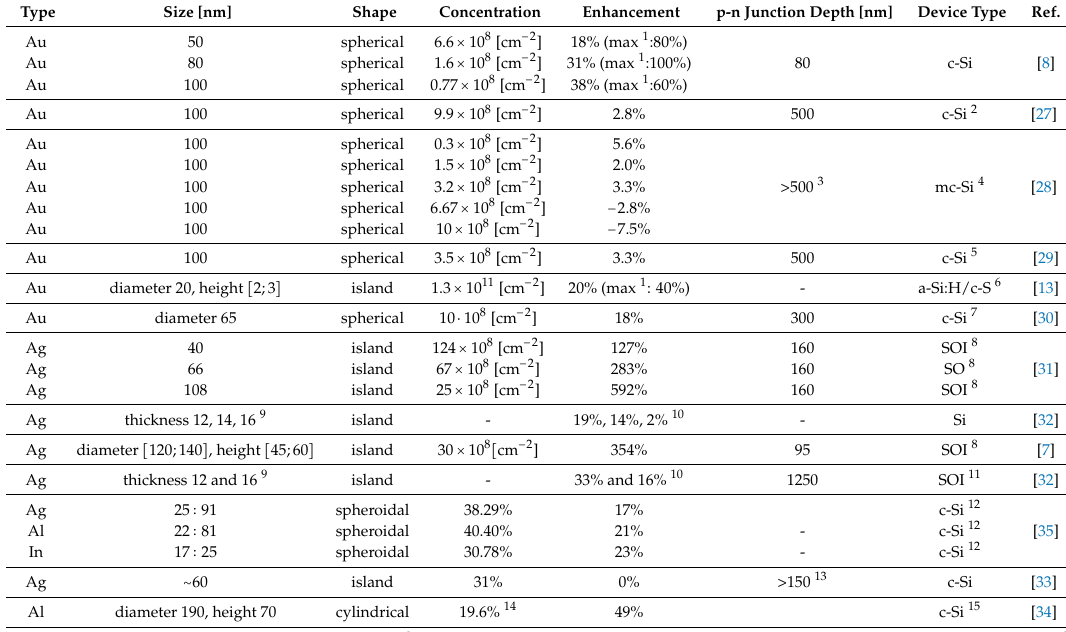
Table 5. Measured values of the photo-current enhancement in silicon solar cells and silicon photo-diodes with deposited metallic nanoparticles. For various setups and nanoparticles deposition parameters the different increase of the photo-effect efficiency has been observed experimentally as reported in the indicated references. Majority of the observed behavior cannot be explained by only local concentration of the e-m field near the curvature of nanoparticles accounted for by the conventional Comsol modeling and the consistence of the experimental data with the theoretical simulation needs inclusion of the plasmon damping contribution as described in the present paper. However, some exceptionally low efficiency increase (or even decrease) evidences the complicated competition of various factors beyond the model considered in the paper, being apparently sensitive to the position of the p-n junction active layer in the substrate or to the interference destructive effects or reflection from too dense